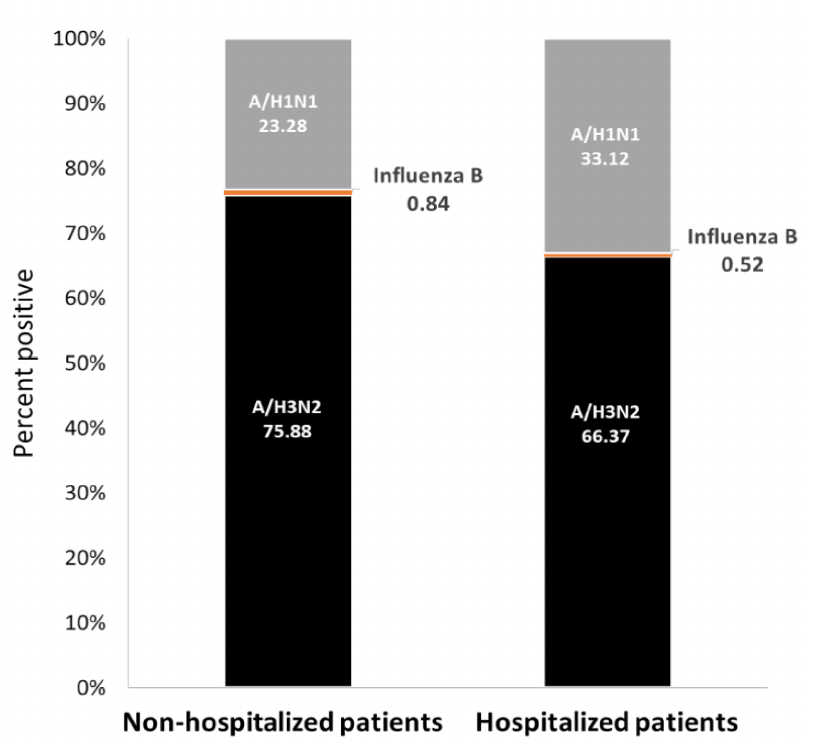
Figure 1. Human influenza infection cases in Israel, winter 2018–19. Data are presented as percentages of reported influenza-positive cases for non-hospitalized and hospitalized